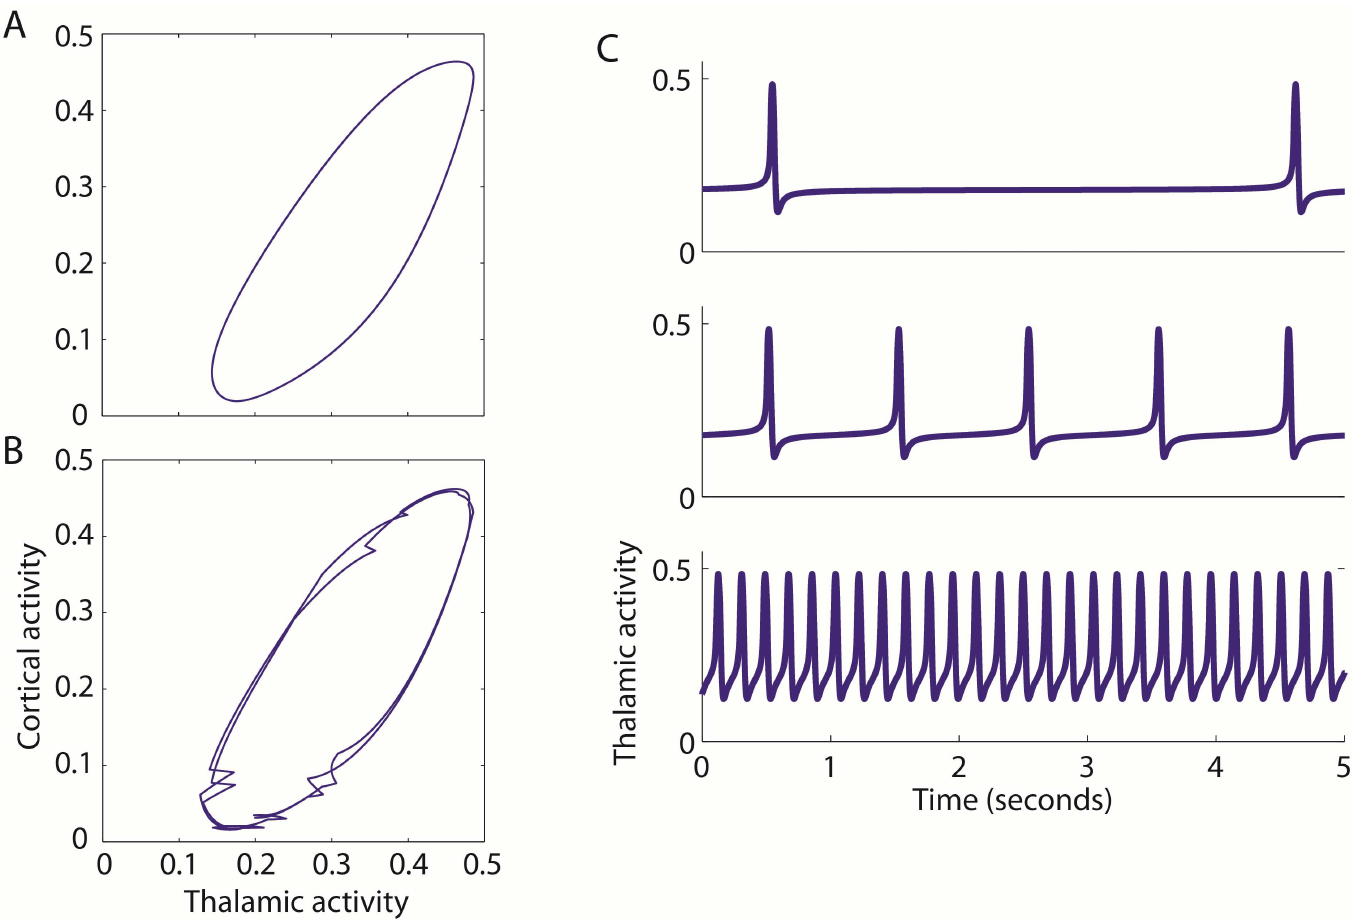
Fig 8. The SNIC bifurcation. The baselineoscillationin the network is describedas a limit cycle, which can be seen when the activities of two populations (Vim and cortex) are plotted againstone another over time (A). When the DBS input is appliedto the network, the limit cycle is no longerconstant and deviates from a perfect cycle over time (B). This is caused by a saddle-nodeon an invariantcircle (SNIC) bifurcation, which can be seen here when the ext parameter value is graduallyincreasedto its value in Table 2